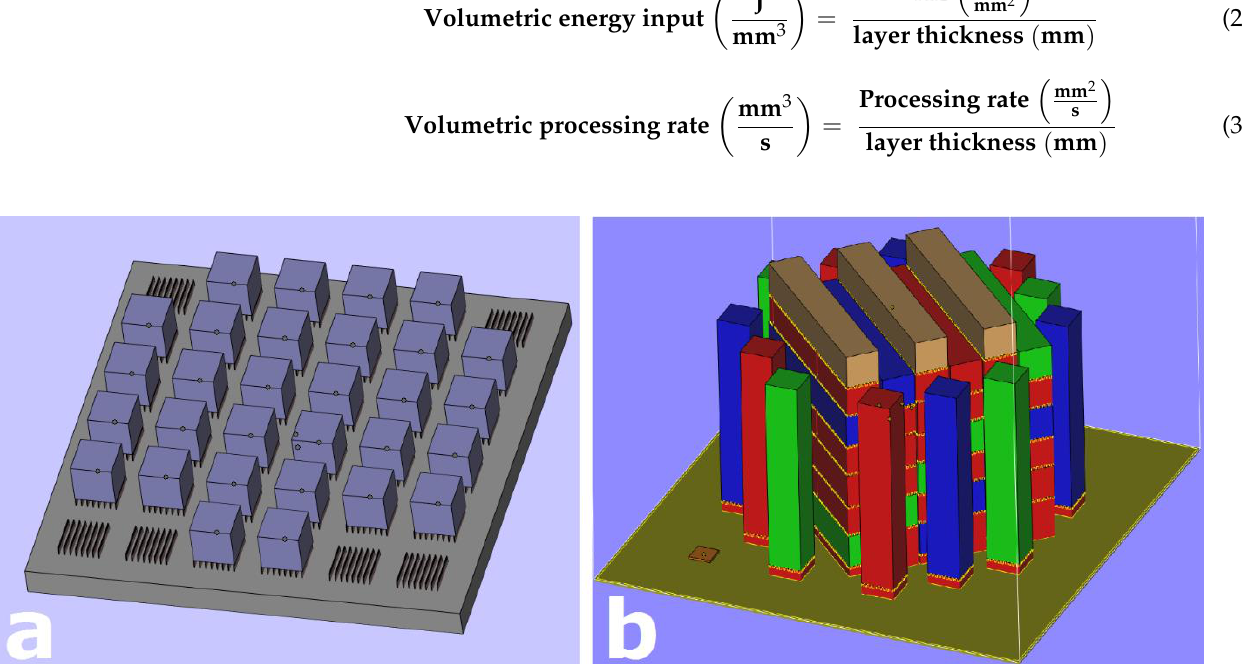
Figure 1. Layouts of builds for sample manufacturing: ( a ) cubes for evaluation of different process parameters; ( b ) layout for tensile bar build.